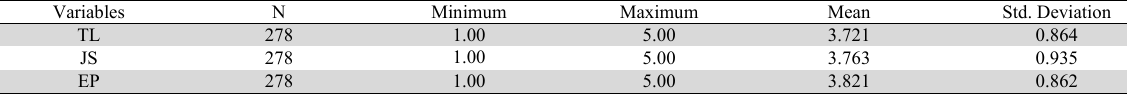
Means and standard deviations of research variables Variables N